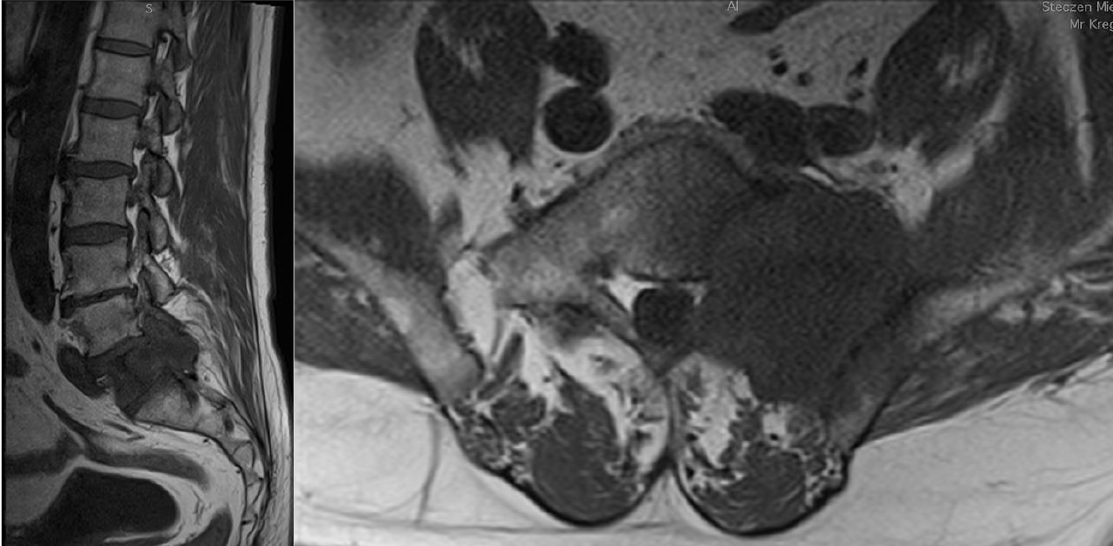
Figure 1. Sagittal and coronal T1-weighted MRI views of a patient diagnosed with sacral metastasis of a pulmonary squamous cell